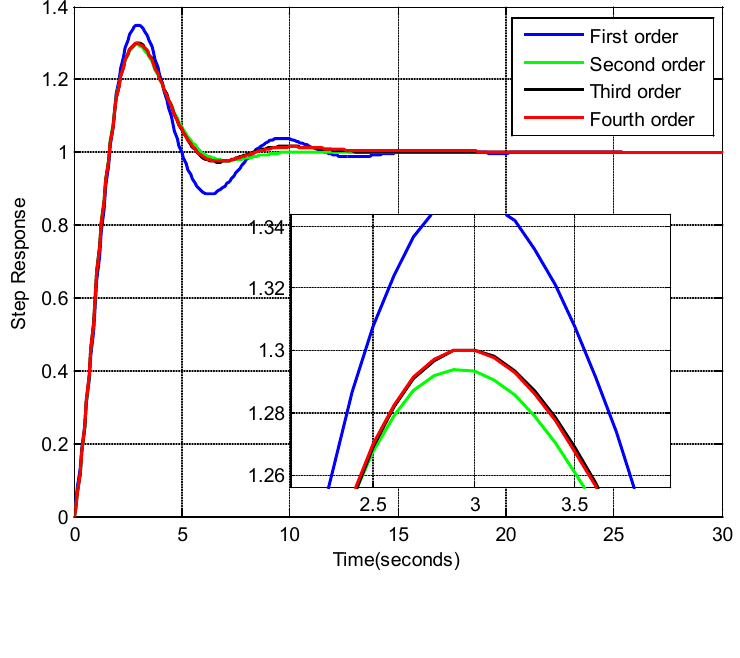
using first, second, third and fourth 1.5 𝐺(𝑠) = 1/(𝑠 + 1)